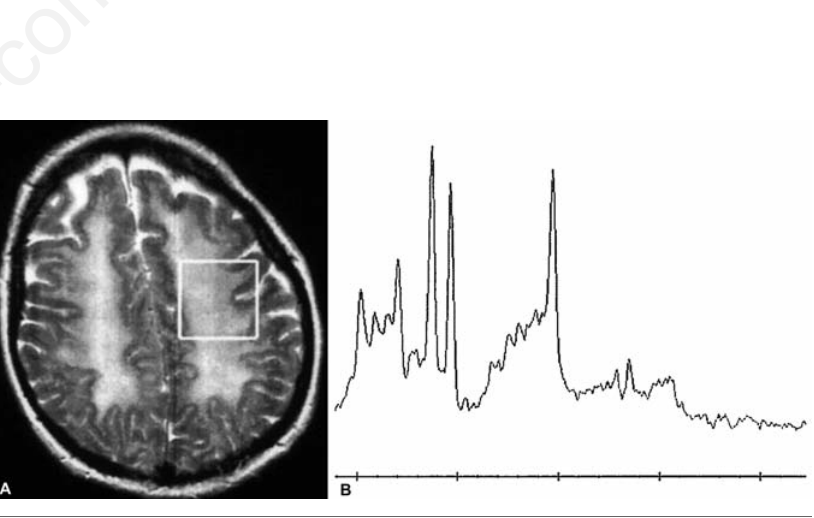
Figure 1. A) Computed tomography appearance at the time of initial development of encephalopathic changes; B) three dimensional reconstruction of coronal T2 sequences obtained with magnetic resonance imaging revealing the extensively confluent subcortical white matter signal hyper-intense change.